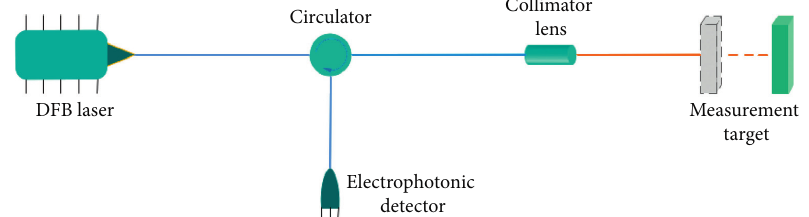
Figure 1: FMCW optical system diagram.